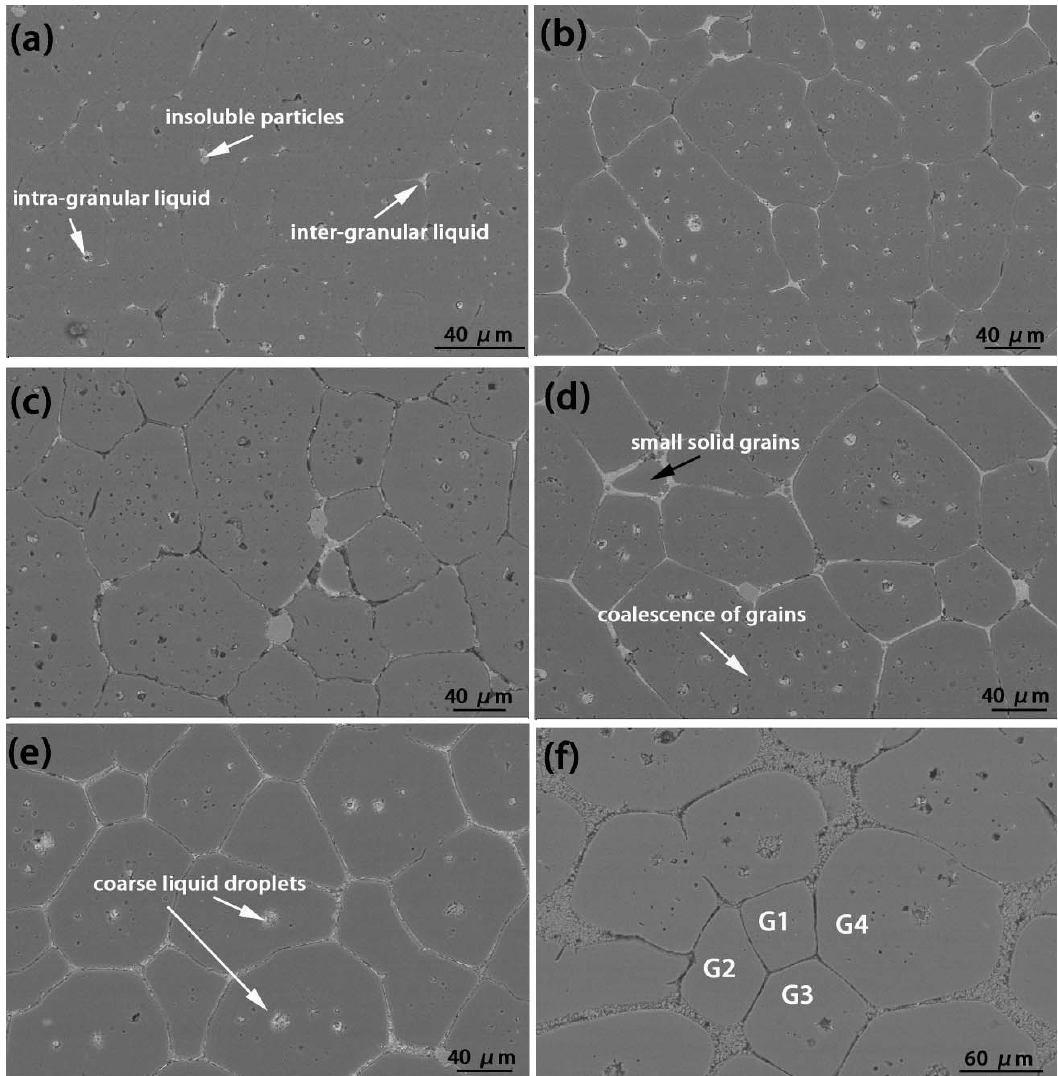
Figure 4. SEM images of the RAP samples after soaked at 610 °C for ( a ) 5 min; ( b ) 10 min; ( c ) 15 min; ( d ) 20 min; ( e ) 25 min and ( f ) 30 min.